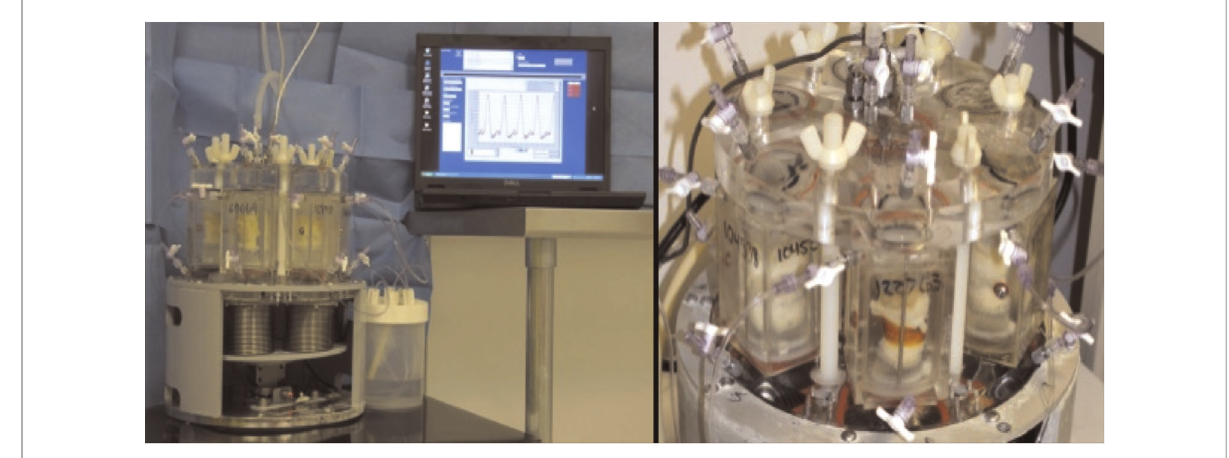
FIGURE 5 Aortic conduits mounted on M-6 Six Position Heart Valve Durability Testing